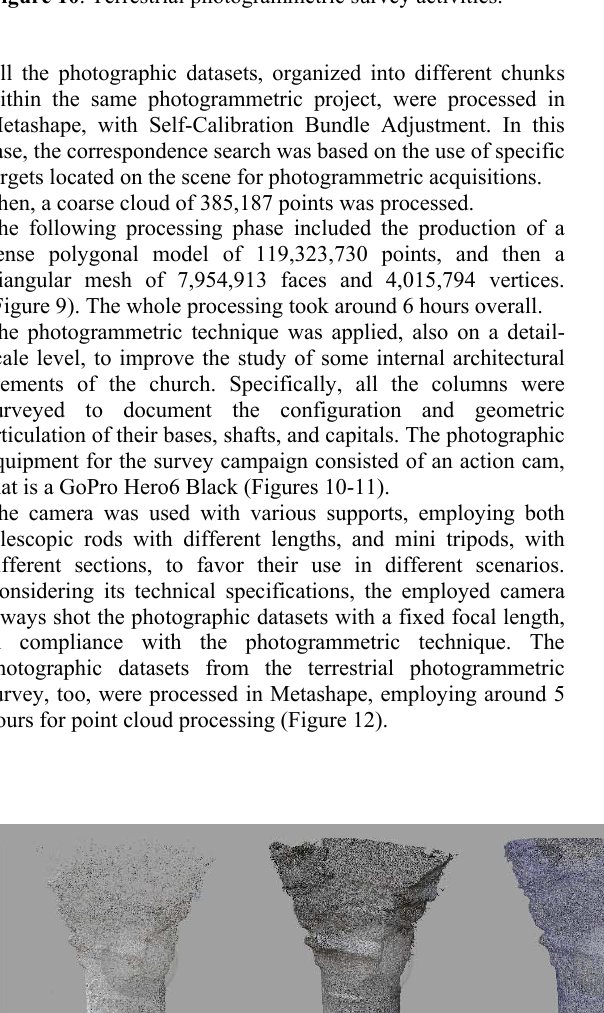
Figure 10 . Terrestrial photogrammetric survey activities.